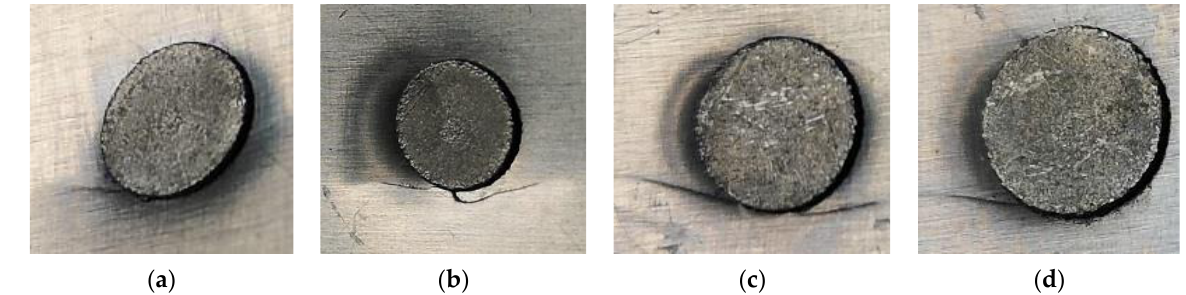
Figure 10. Failure forms of AA-SPFC joints with rivet heights of ( a ) 6 mm; ( b ) 7 mm; ( c ) 8 mm; ( d ) 9 mm.